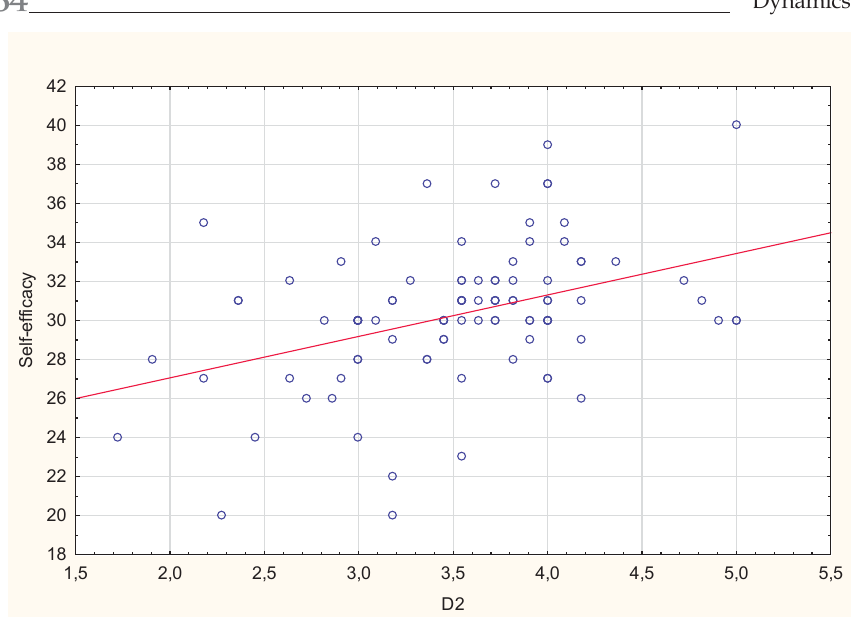
Figure 5. (cid:55)(cid:75)(cid:72)(cid:3)(cid:86)(cid:70)(cid:68)(cid:87)(cid:87)(cid:72)(cid:85)(cid:3)(cid:71)(cid:76)(cid:68)(cid:74)(cid:85)(cid:68)(cid:80)(cid:3)(cid:178)(cid:3)(cid:54)(cid:72)(cid:79)(cid:73)(cid:16)(cid:72)(cid:73)(cid:192)(cid:70)(cid:68)(cid:70)(cid:92)(cid:3)(cid:87)(cid:82)(cid:3)(cid:80)(cid:72)(cid:81)(cid:87)(cid:68)(cid:79)(cid:3)(cid:90)(cid:72)(cid:79)(cid:79)(cid:16)(cid:69)(cid:72)(cid:76)(cid:81)(cid:74)(cid:3)(cid:11)(cid:39)(cid:21)(cid:12)(cid:3)(cid:73)(cid:82)(cid:85)(cid:3)(cid:87)(cid:75)(cid:72)(cid:3)(cid:68)(cid:81)(cid:68)(cid:79)(cid:92)(cid:93)(cid:72)(cid:71)(cid:3) (cid:74)(cid:85)(cid:82)(cid:88)(cid:83) Table 1.